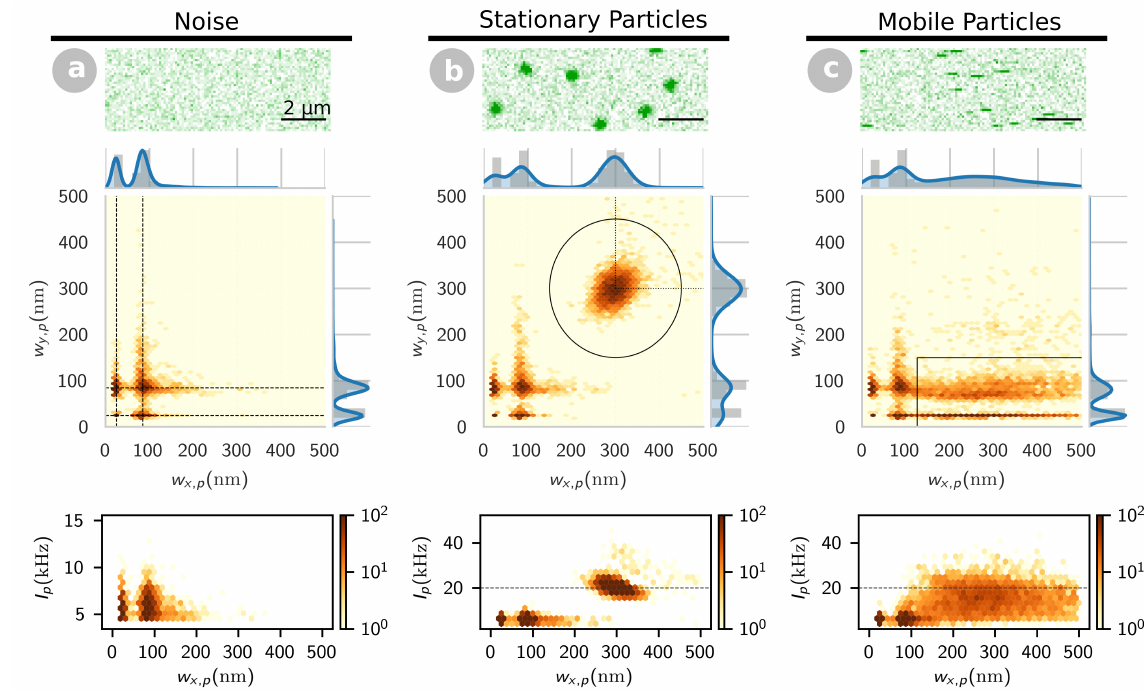
Figure 1. Confocal image simulations for ( a ) background Poisson noise ( i B = 1.3 kHz), ( b ) stationary particles ( B = 20 kHz) and ( c ) mobile particles ( D = 2 µm 2 s − 1 , B = 20 kHz). For each condition, a single image section is shown as an example (top panel), as well as the particle size distribution (eccentricity map) generated from the analysis of a large number of such images (middle panel), and the relationship between particle width and intensity (bottom panel). In the eccentricity map in ( a ), the dashed lines indicate the position of the two peaks corresponding to spurious photon noise events. In ( b ), the dashed lines show the expected dimensions of an immobile particle ( w 0 both along and perpendicular to the scanning direction), and the circle delimitates the area in which particles are considered “spots”. In ( c ), the rectangle delimitates the area in which the particles are considered “streaks”. In the bottom panels in ( b , c ), the dashed line indicates the value of the molecular brightness, B